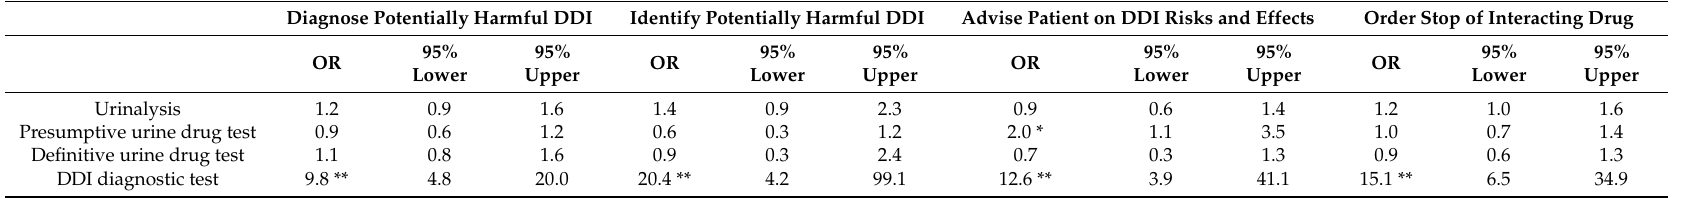
Table 9. DDI-Specific Logistic Regression Results of Different Urine Tests †